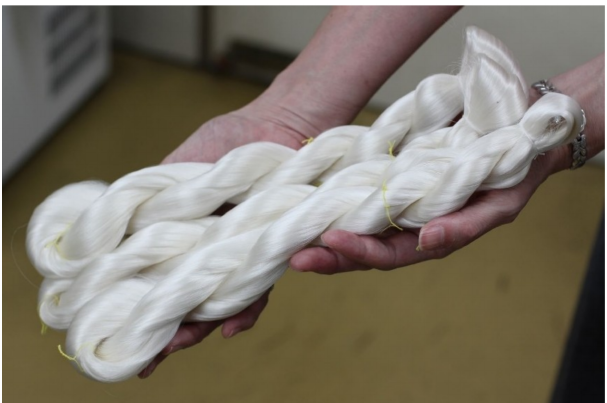
Figure 2. Picture of three bundles of the azido-functionalized raw silk fiber. Around 160 g of raw silk fiber was produced in total by rearing circa 1000 larvae of the F 1 hybrid, H06 × (Nichi509 × Nichi510). The larvae were fed AzPhe-containing diet (0.05 wt% in dry diet) on their third day of fifth instar until the start of spinning.